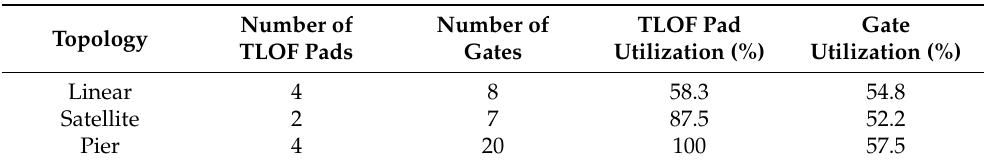
Table 10. Results of each topology for the expanded Gimpo parking lot space that complies with the EASA’s new regulations.